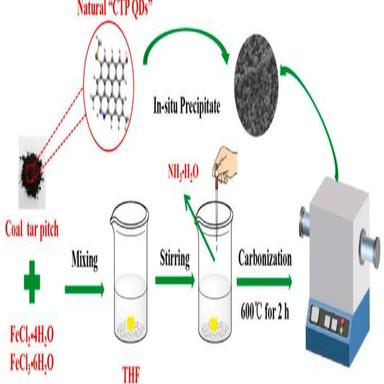
Schematic illustration of the preparation of Fe3O4@CTP QDs composites.